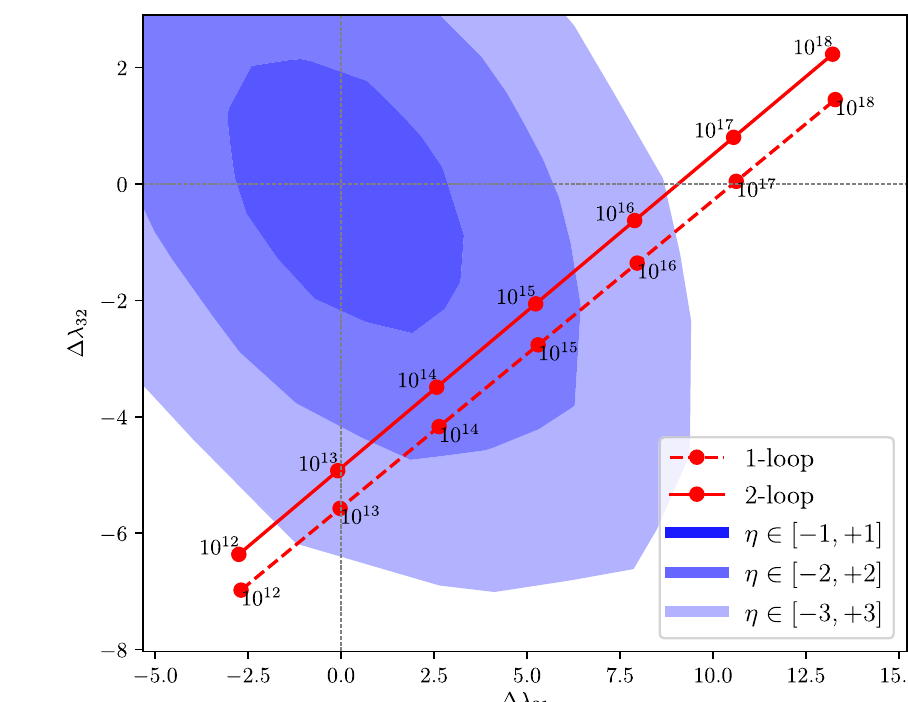
Fig. 2 Threshold effects to allow for unification of the SM gauge couplings. The difference between gauge couplings α − 1 − α − 1 − α − 1 and α − 1 is 3 2 2 1 shown in the solid (dashed) red line at two-loop (one-loop) level. Numbers above the lines are the energy scales in units of GeV. The blue shaded regions show the size of the threshold corrections. Intersections between the blue shaded regions and the red lines correspond to successful gauge coupling